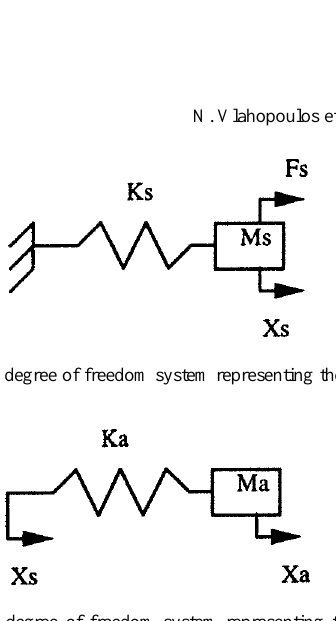
Fig. 4. Single degree of freedom system representing the acoustic